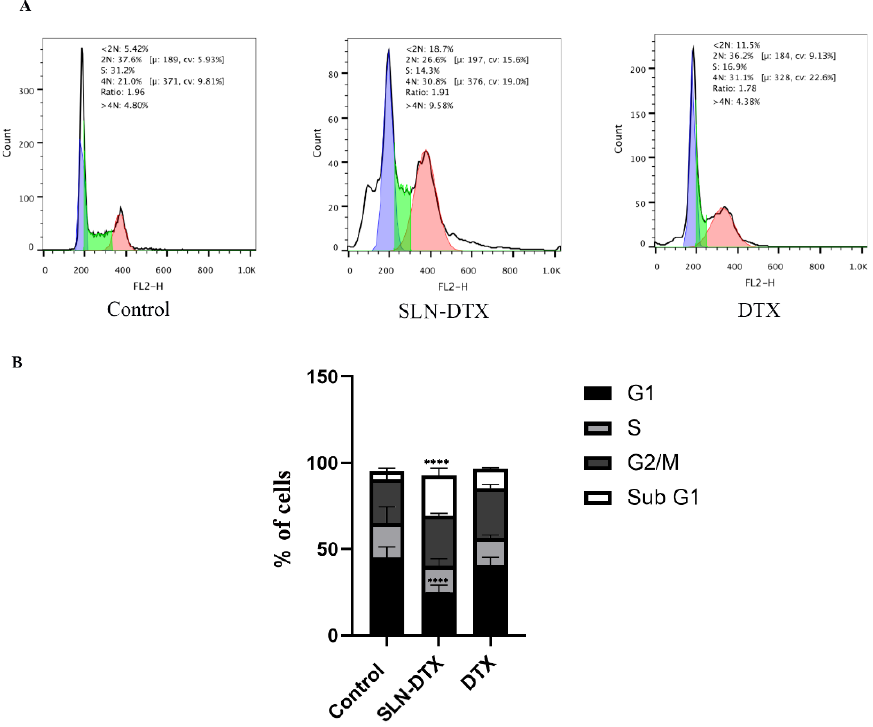
Figure 10. Cell cycle analysis of MDA-MB-231 after treatments. ( A ) Histograms of cell cycle phases, untreated cells, and cells treated with SLN-DTX and with DTX. Purple are cells in 2N, green are cells in S and pink are cells in 4N. ( B ) Quantification of the percentage of cells in each phase of the cell cycle. The results presented are from three independent experiments, with the mean percentage of cells in each cell cycle phase ± SEM. **** p < 0.0001 when compared to the control.